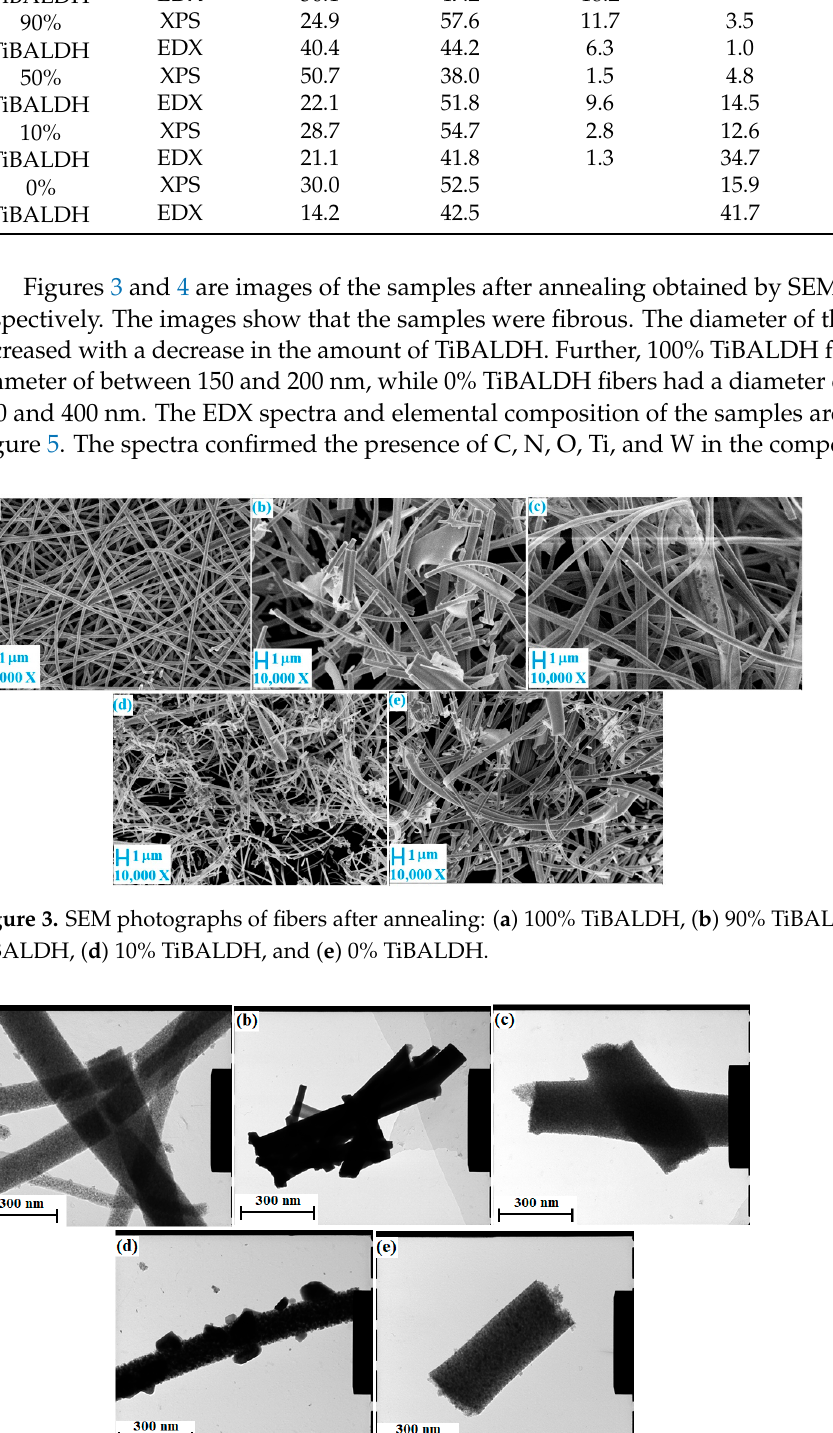
Table 1. Elemental composition of the annealed fibers based on XPS and energy-dispersive X-ray (EDX).